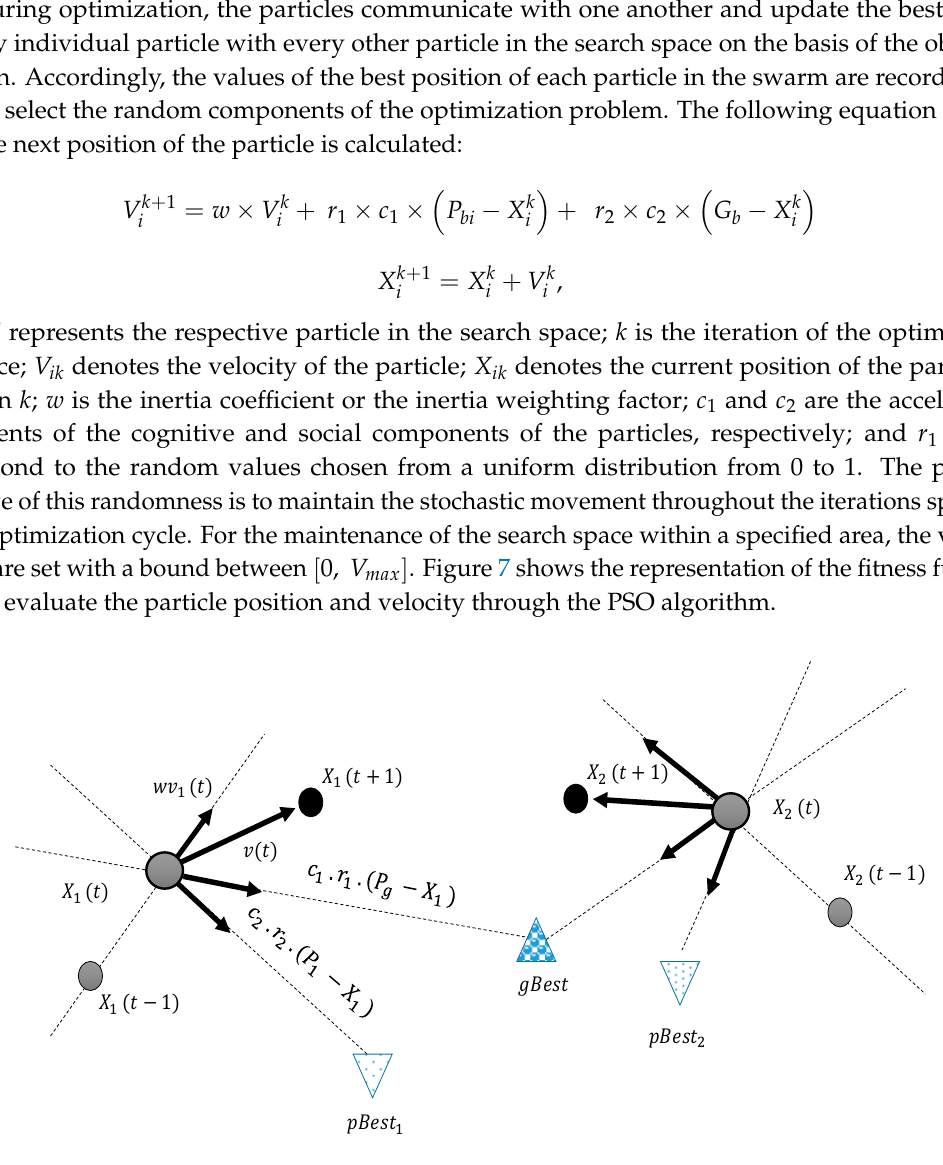
Figure 6. Pictorial representation of PSO algorithm in a three-dimensional search space.